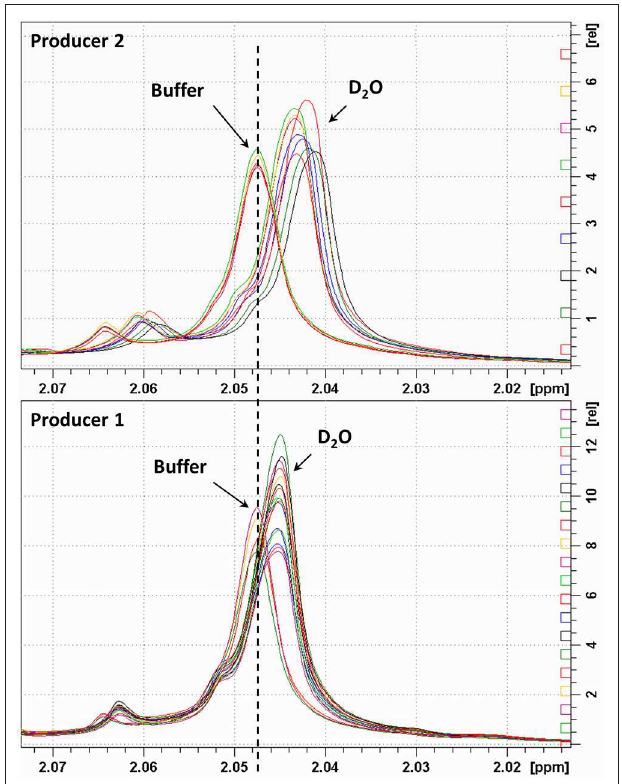
FIGURE 3 | Acetyl signal of heparin 1H-NMR spectra registered in D 2 O or buffer. Top and bottom panels show samples of two different manufacturers.